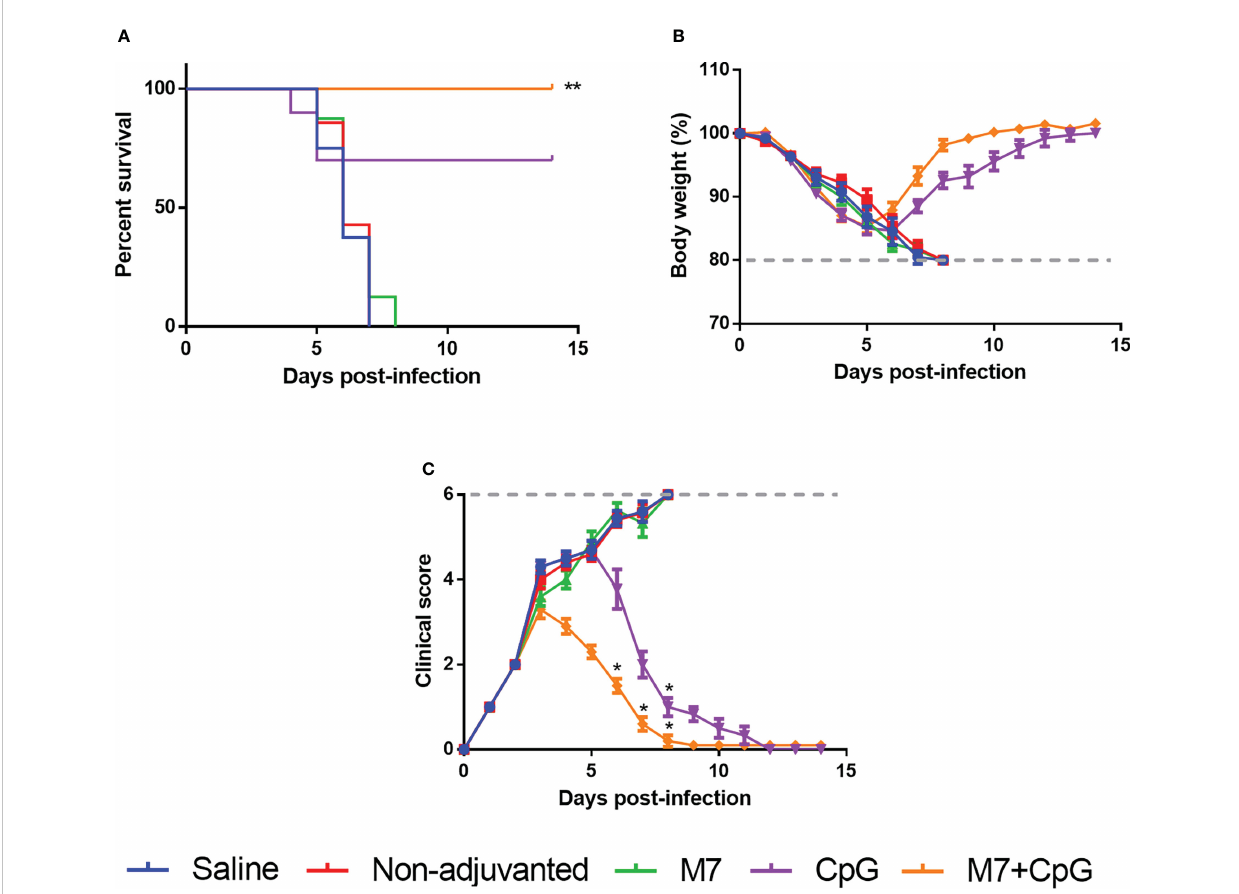
FIGURE 7 Vaccination with M7-CpG NPs and J4 COBRA protects against the H3 in fl uenza virus challenge. C57BL/6 mice ( n = 10) were intranasally immunized with saline, non-adjuvanted J4, M7 + J4, CpG + J4, and M7-CpG NPs + J4 on days 0, 21, and 35. Mice were challenged on day 56 with 1K PFUs of the A/Hong Kong/1/68 mouse-adapted virus. (A) Mice survival, (B) body weight, and (C) clinical score were evaluated for the different groups ( n = 10). Data are presented as mean ± range. Signi fi cant differences were determined using a survival statistic and two-way ANOVA test with Tukey ’ s comparison against the saline group (* p ≤ 0.05; ** p ≤